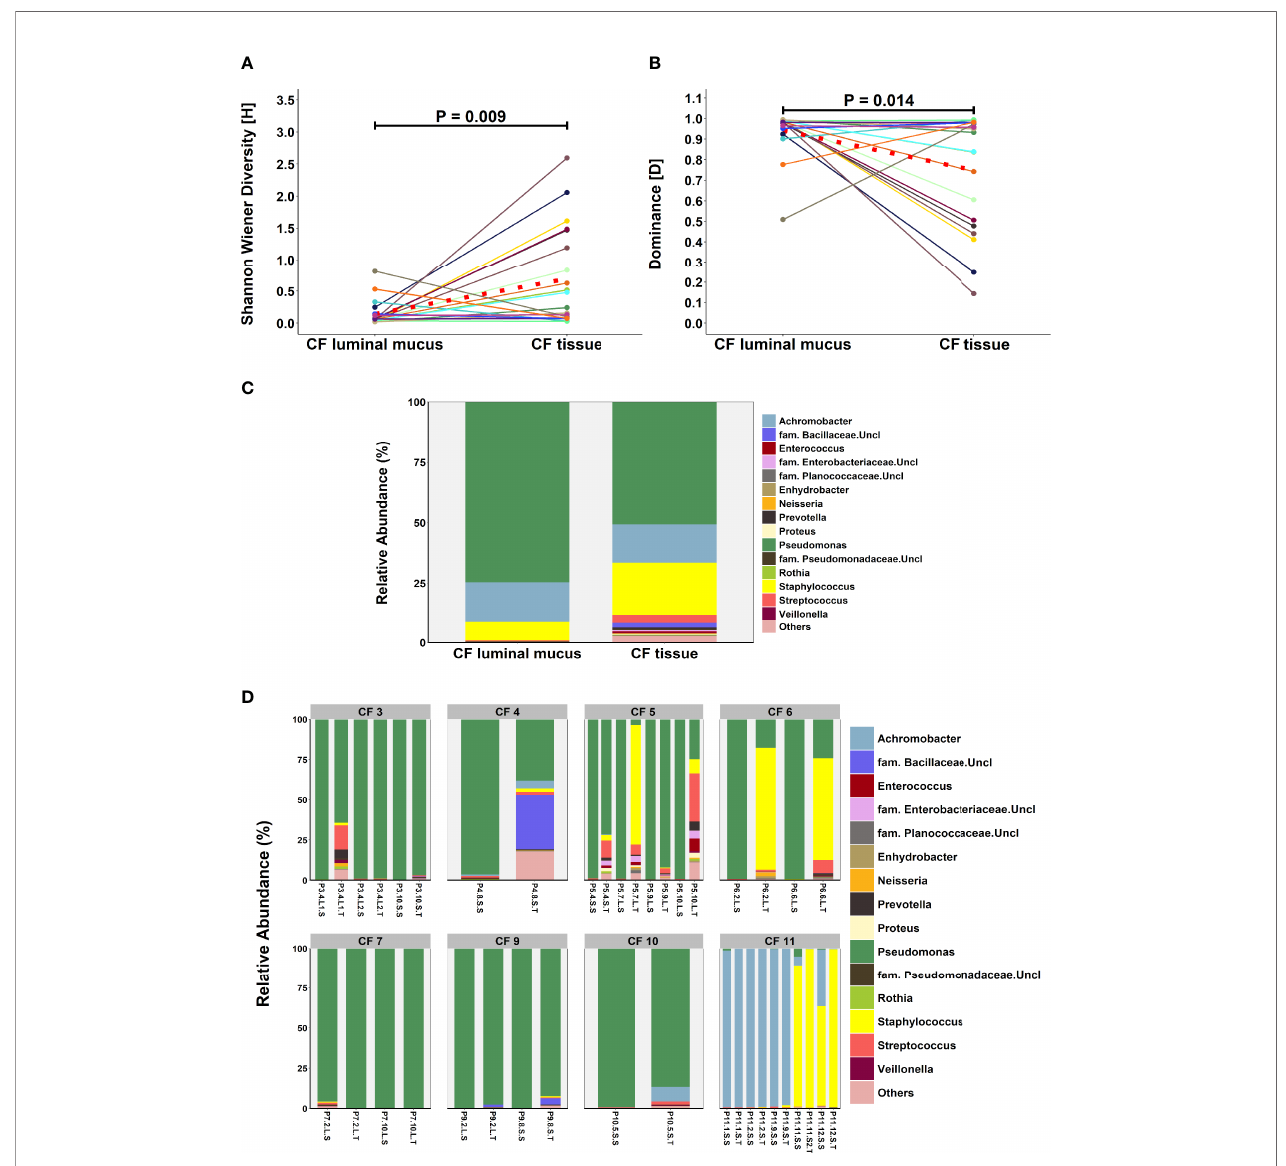
FIGURE 4 | Comparison of microbial community composition in matched CF tissue and luminal mucus samples (n=20) (A) Shannon-Wiener diversity (B) dominance (C) mean relative abundance of all genera present >1% RA. (D) relative abundance for individual matched patient samples of all genera present >1% RA. Sample names are denoted as: Px.x, patient/lung-slice number (from apex to base); (Px.x.) S/L, small or large airway; (Px.x.S/L.) S/T, luminal mucus or tissue. For panels (A, B) , the red dotted line denotes difference in